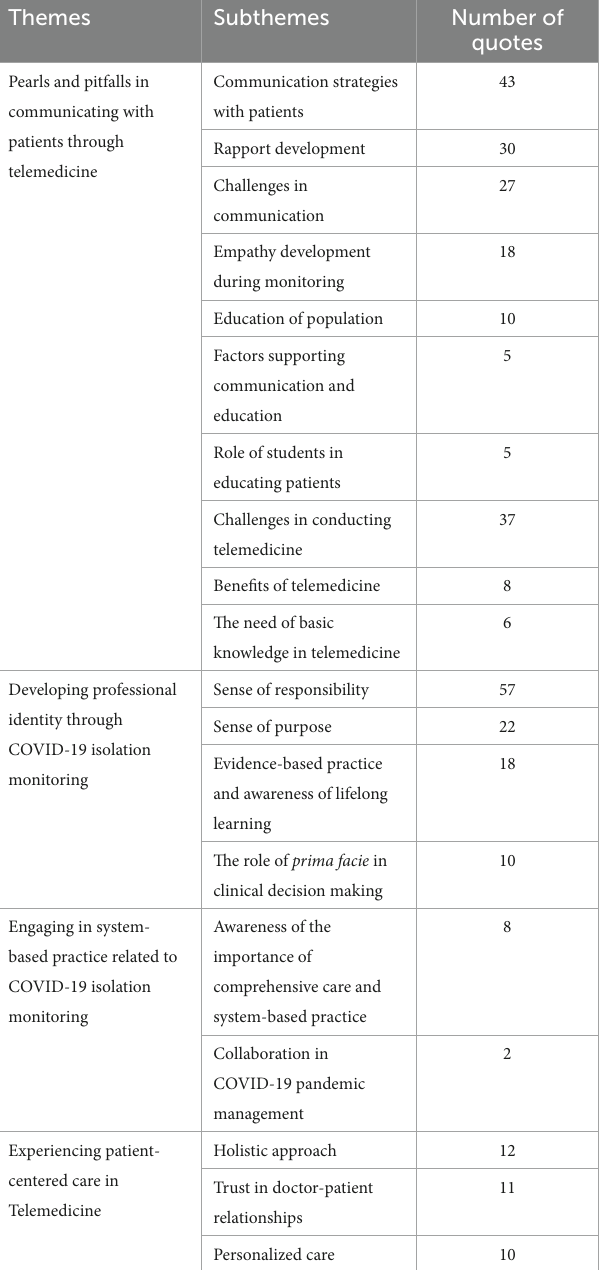
TABLE 1 Themes and subthemes gathered from the study.